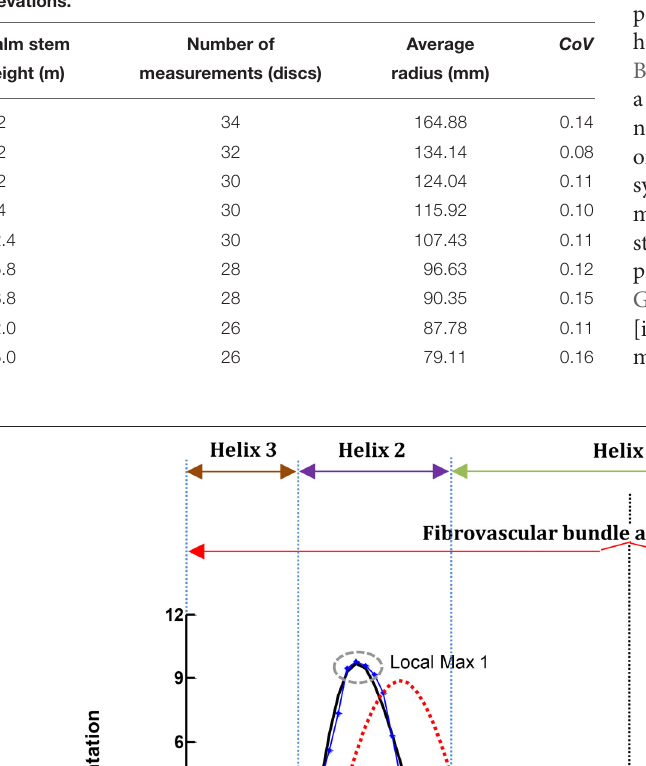
Frontiers in Plant Science |